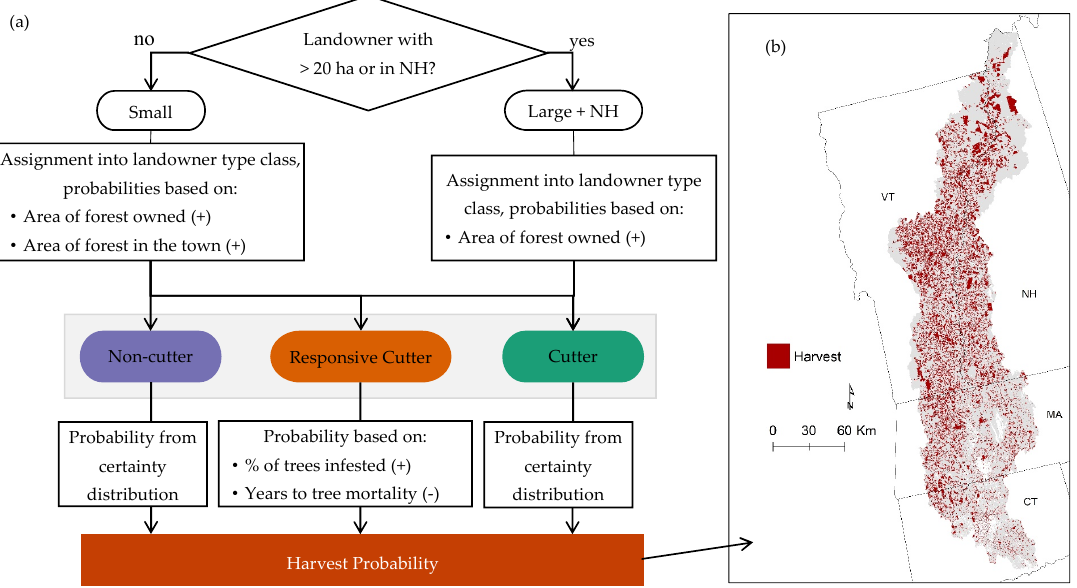
Figure 2. a) Process for assigning agent functional types to FFO parcels in the Connecticut River Watershed. We used the agent functional types, survey response certainty distributions, and specifics from the emerald ash borer (EAB) invasion to calculate harvest probabilities for each parcel. The relationships between probability of being classified as a Cutter landowner type or with higher probability of harvest are shown in parenthesis. b) An example harvest parcel map where red areas are parcels selected for harvest in one replicate.